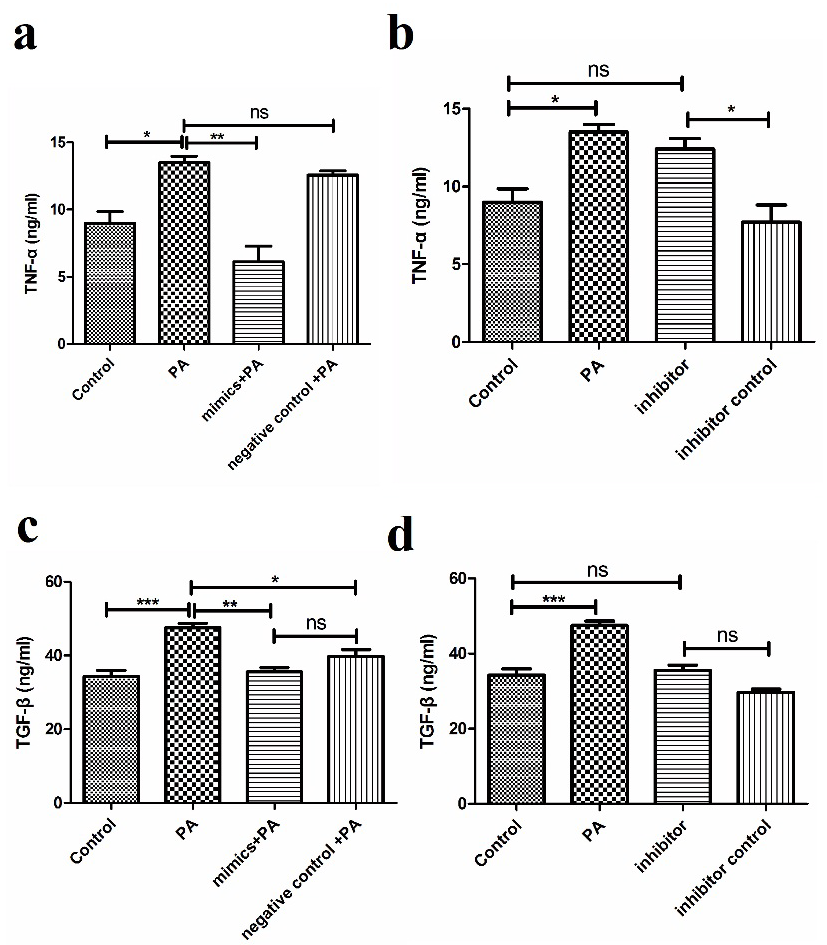
Figure 3. miR-194 reduces TLR4-activated inflammatory cytokine release in THP-1 cells. THP-1 cells were transfected with miR-194 mimics, inhibitor, their control for 24 h and followed 250 μM PA exposure for 8 h. Supernatants were collected to measure TNF-α and TGF-β by ELISA. ( a , b ) represent TNF-α; ( c , d ) show the change of TGF-β level. Results are mean ± SD. * p < 0.05 and ** p < 0.01, *** p <